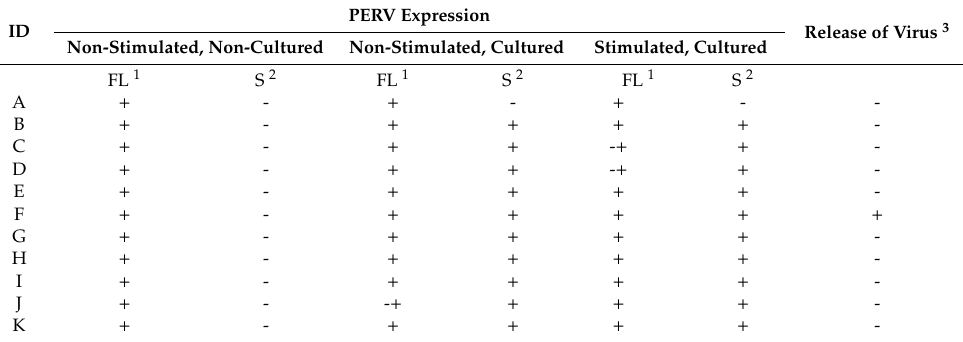
Table 3. Expression of PERV in stimulated and unstimulated PBMCs from GöMP.